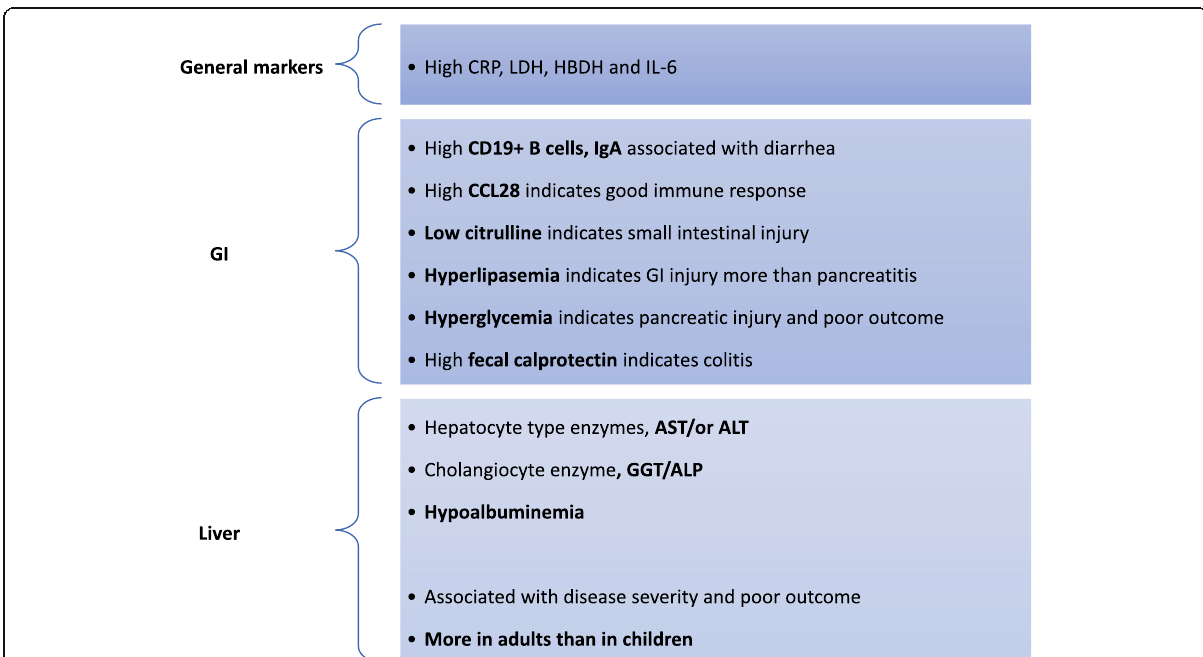
Fig. 3 Laboratory findings in COVID-19 patients presented with GI or liver affection. CRP, C-reactive protein; LDH, lactate dehydrogenase; HBDH, α -hydroxybutyrate dehydrogenase; CCL28, chemokine (C-C motif) ligand 28; GGT, gamma-glutamyl transferase; AST, aspartate aminotransferase; ALT, alanine aminotransferase; ALP, alkaline phosphates; IL-6,